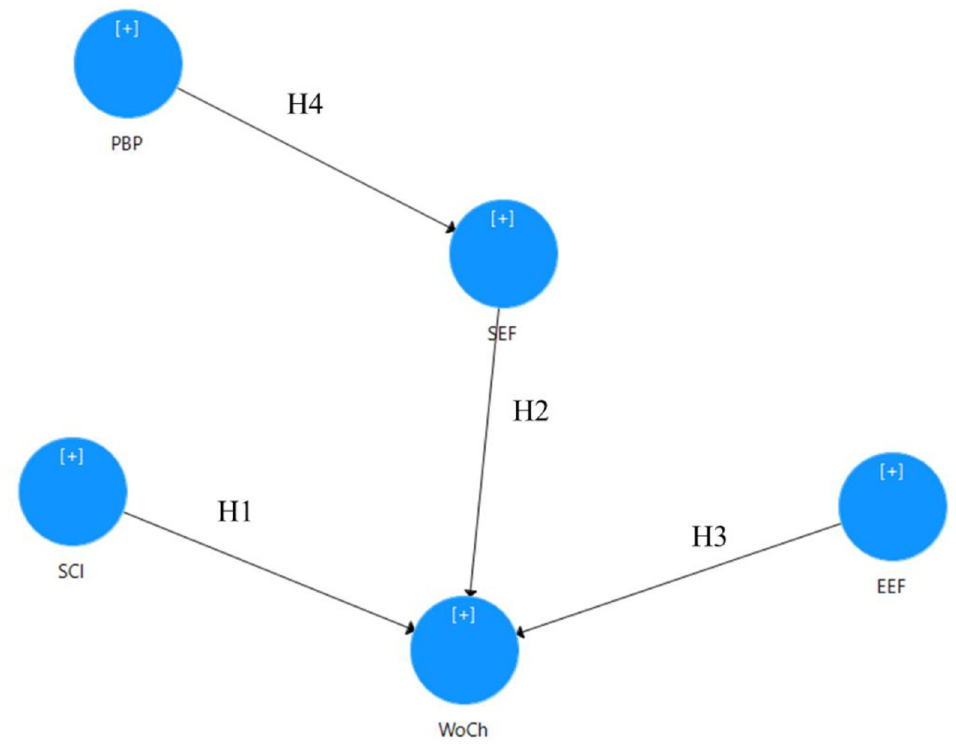
Fig 1. Hypotheses